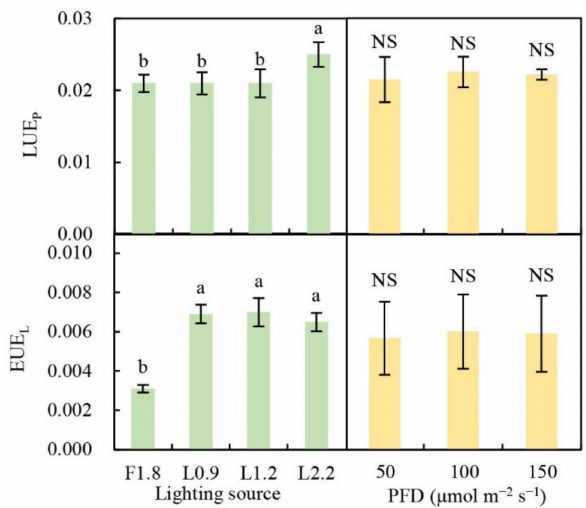
Figure 7. Effects of light quality during the whole seedling period and photon flux density (PFD) in the healing stage on energy use efficiency of grafted tomato transplants. There were no interactive effects of light quality and PFD on LUE P ( P = 0.212) and EUE L ( P = 0.063). Duncan’s test was used to make post-hoc multiple comparisons at α = 0.05 level ( n = 6). Vertical bars represent standard deviations. Different letters, a and b, indicate significant differences and NS indicates nonsignificant